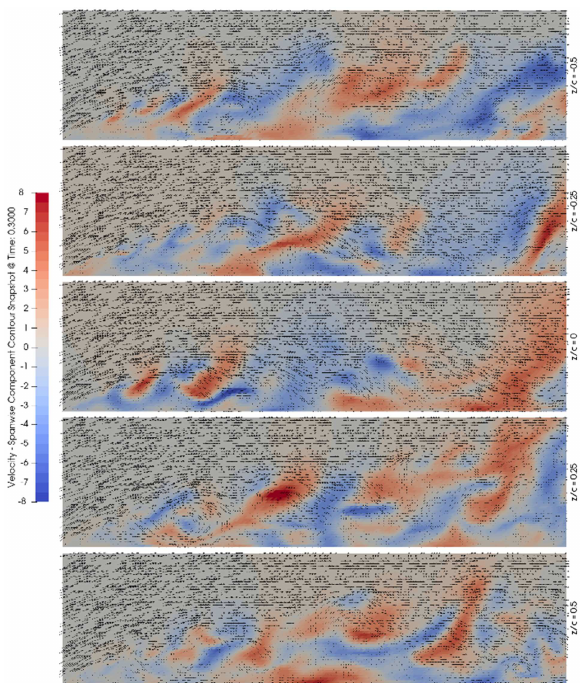
Fig. 4. Spanwise normal planes above plate suction surface. Instantaneous spanwise velocity contours and vectors of instantaneous in-plane velocity.